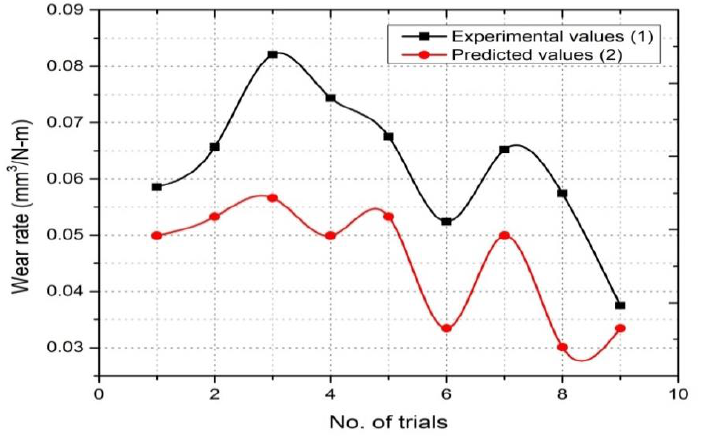
Fig. 3. Comparison of wear rates between experimental and expected values.